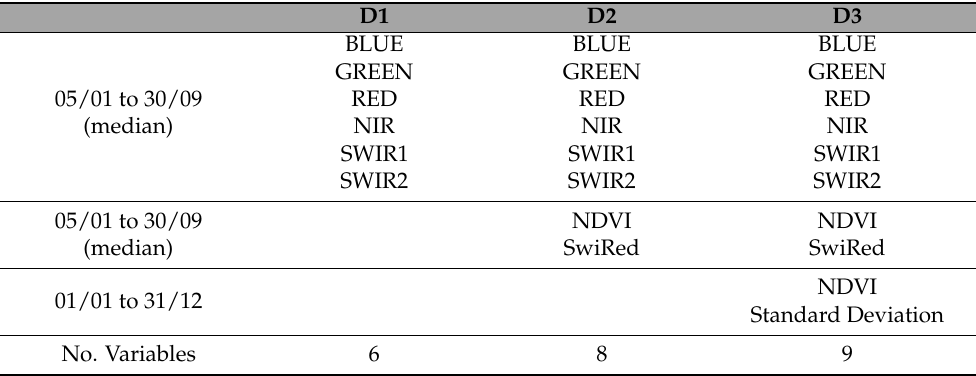
Table 1. Composition of datasets used to train and validate the classification models. D1 D2